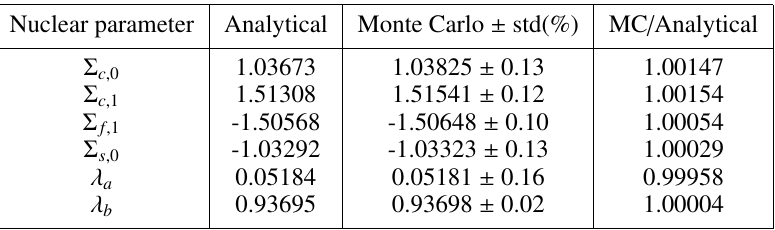
Table 2: Infinite medium model. Sensitivity coe ffi cients S parameters x as computed by Monte Carlo using the super-history method for p